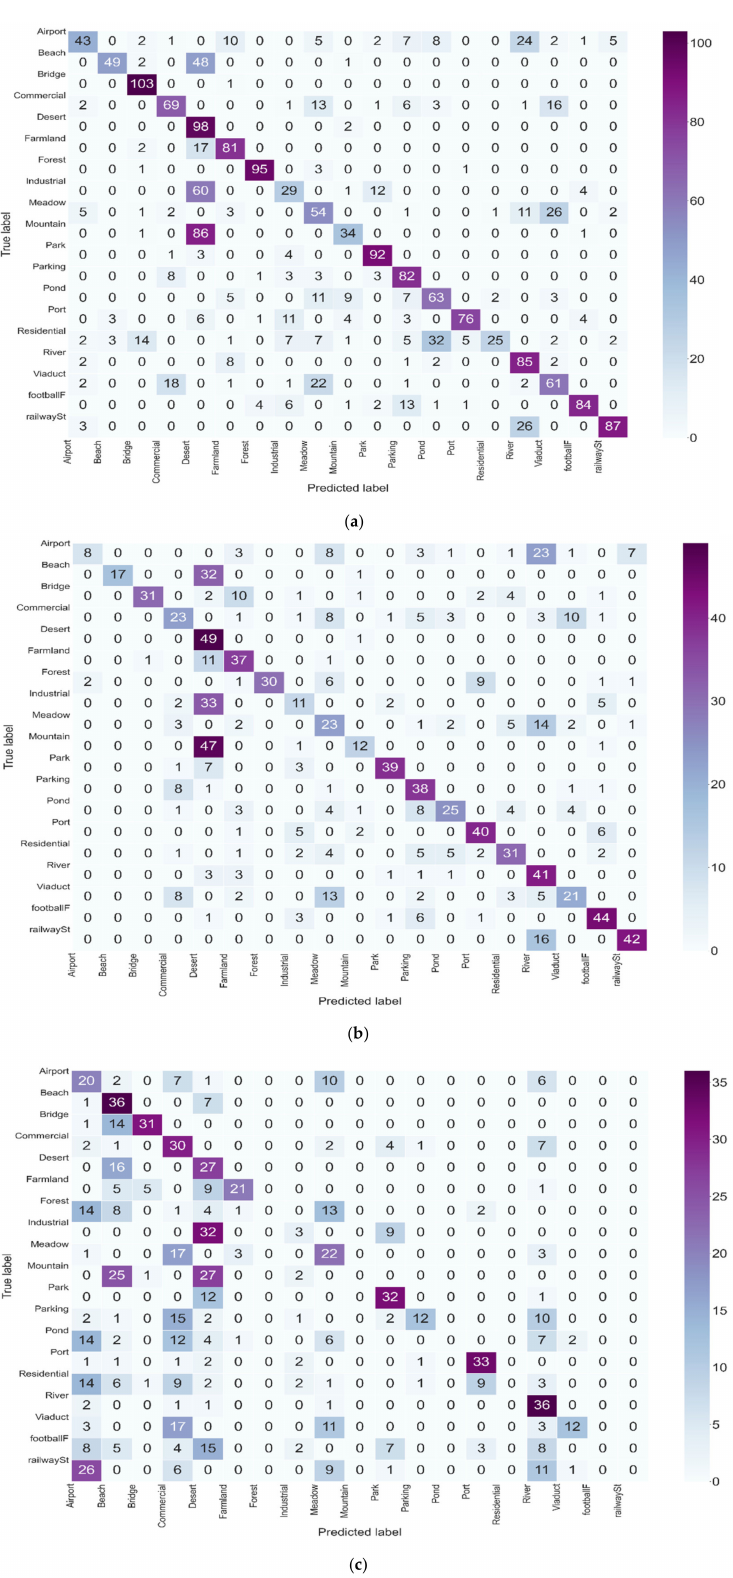
Figure 13. Comparisons of confusion matrices on the three different datasets in UC Merced Land-Use Dataset. ( a ) Datasets with fake samples generated by the improved SinGAN, ( b ) Datasets with true samples used for the training of the improved SinGAN, ( c ) Datasets with random samples selected randomly by the classifier